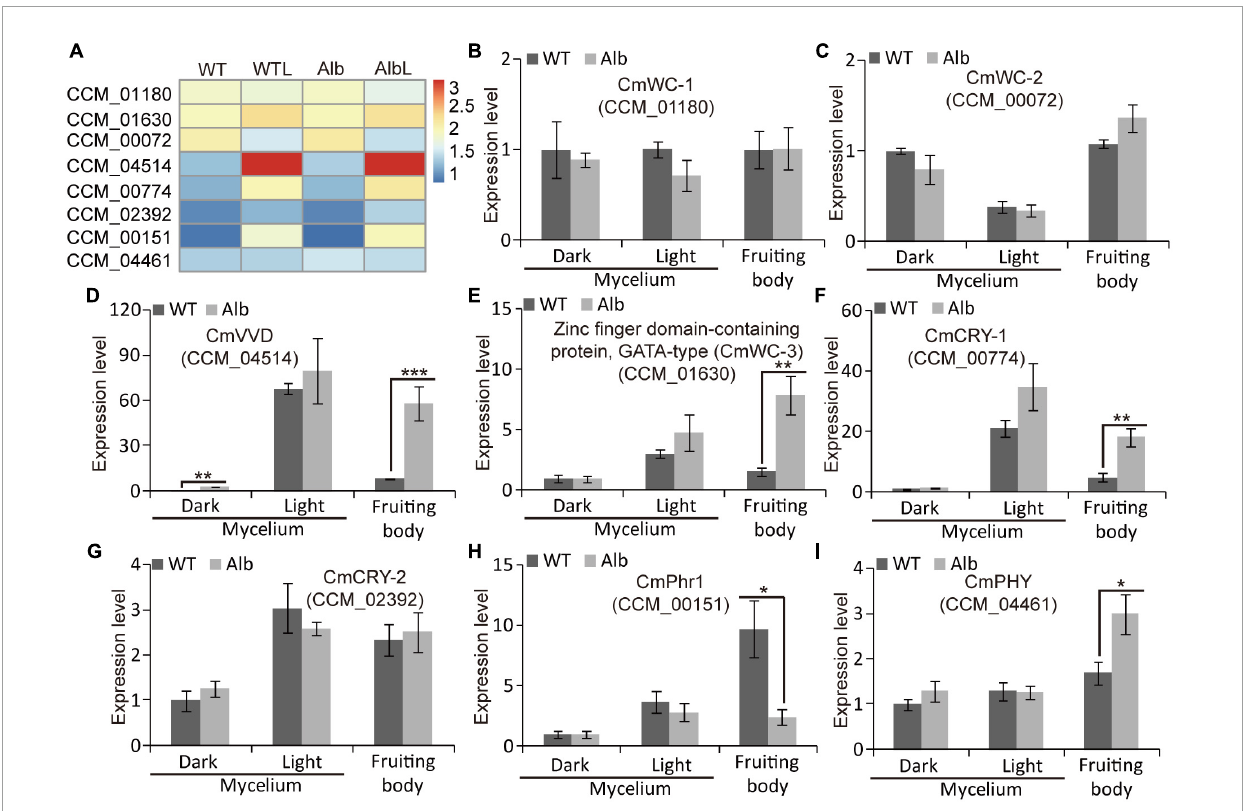
FIGURE6 Expression analysis of photoresponsive genes in WT and Alb . (A) Heatmap analysis of CmWC-1 (CCM_01180), CmWC-2 (CCM_00072), CmVVD (CCM_04514), CmWC-3 (CCM_01630), CmCRY-1 (CCM_00774), CmCRY-2 (CCM_02392), CmPhr1 (CCM_00151), and CmPHY (CCM_04461) based on their FPKM values in the WT, WTL, Alb , and AlbL samples; (B–I) expression analysis of the eight genes in the mycelia under dark and light treatment, and fruiting body. One, two, and three asterisks denote significance relative to WT (Student’s t -test; * p < 0.05, ** p < 0.01, and *** p <